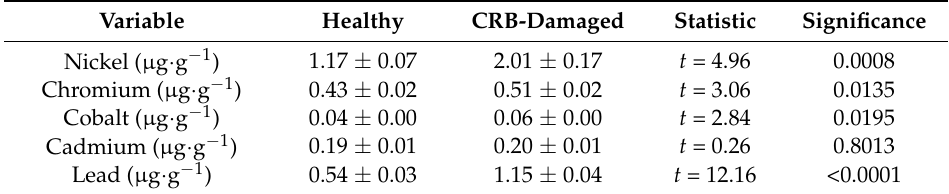
Table 3. The influence of coconut rhinoceros beetle (CRB) herbivory on green coconut leaflet metal content. Mean ± standard error, n =